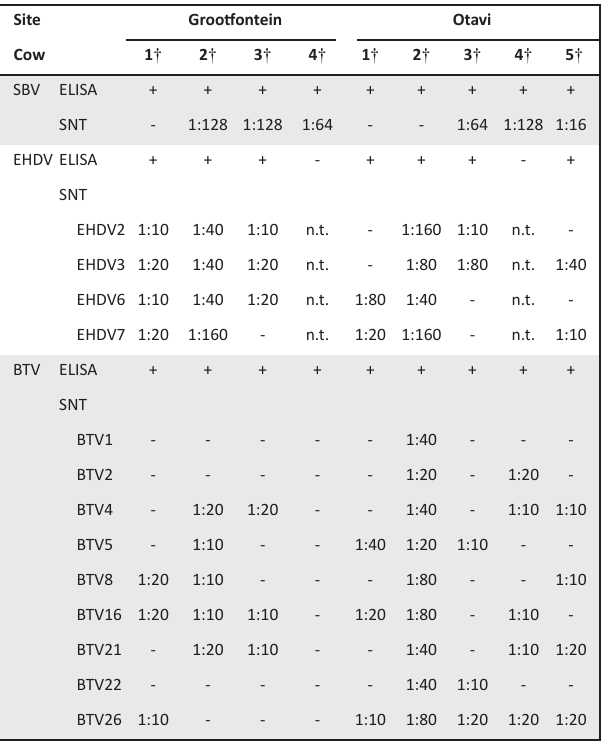
FIGURE 1: Details of serological results for antibodies to Schmallenberg virus, epizootic haemorrhagic disease virus and bluetongue virus in nine